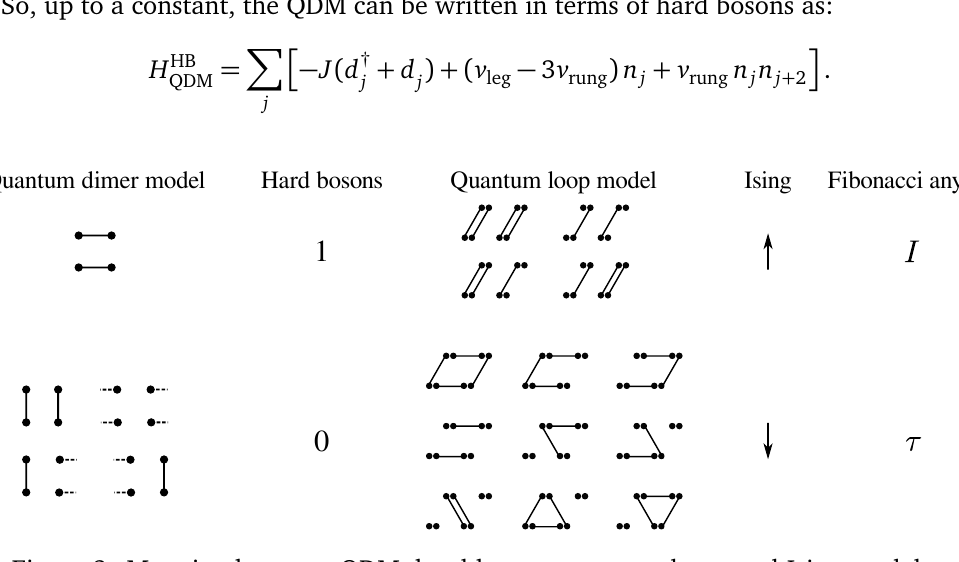
Figure 2: Mapping between QDM, hard-boson, quantum loop, and Ising models on two-leg ladder. At the tricritical Ising point these models have an exact mapping to the Fibonacci anyon